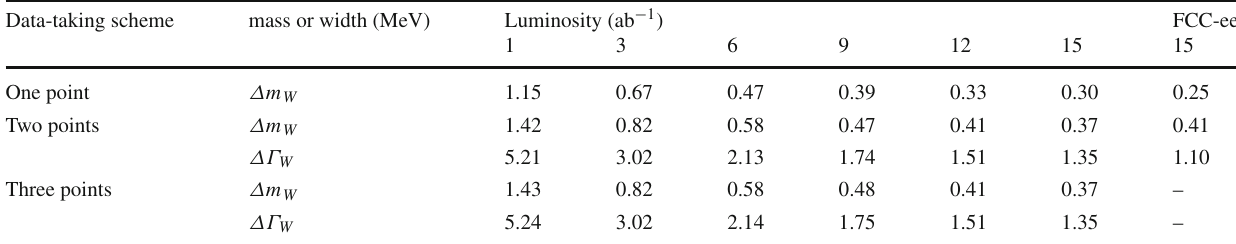
Table 4 The expected precisions of m W and Γ W with the optimized data-taking schemes, corresponding to different luminosity inputs (sta- tistical uncertainties only). The last column is the result of FCC-ee, where the systematic uncertainties are reckoned to be under control to a negligible level of impact [33]. Several systematic uncertainties have been studied in section 3.2, and the numerical results with the assump-